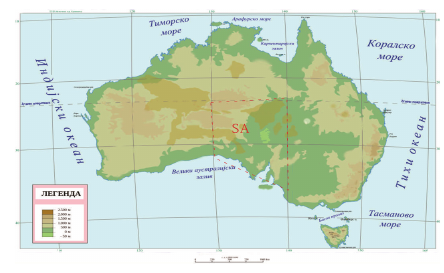
Figure 2: Study area.